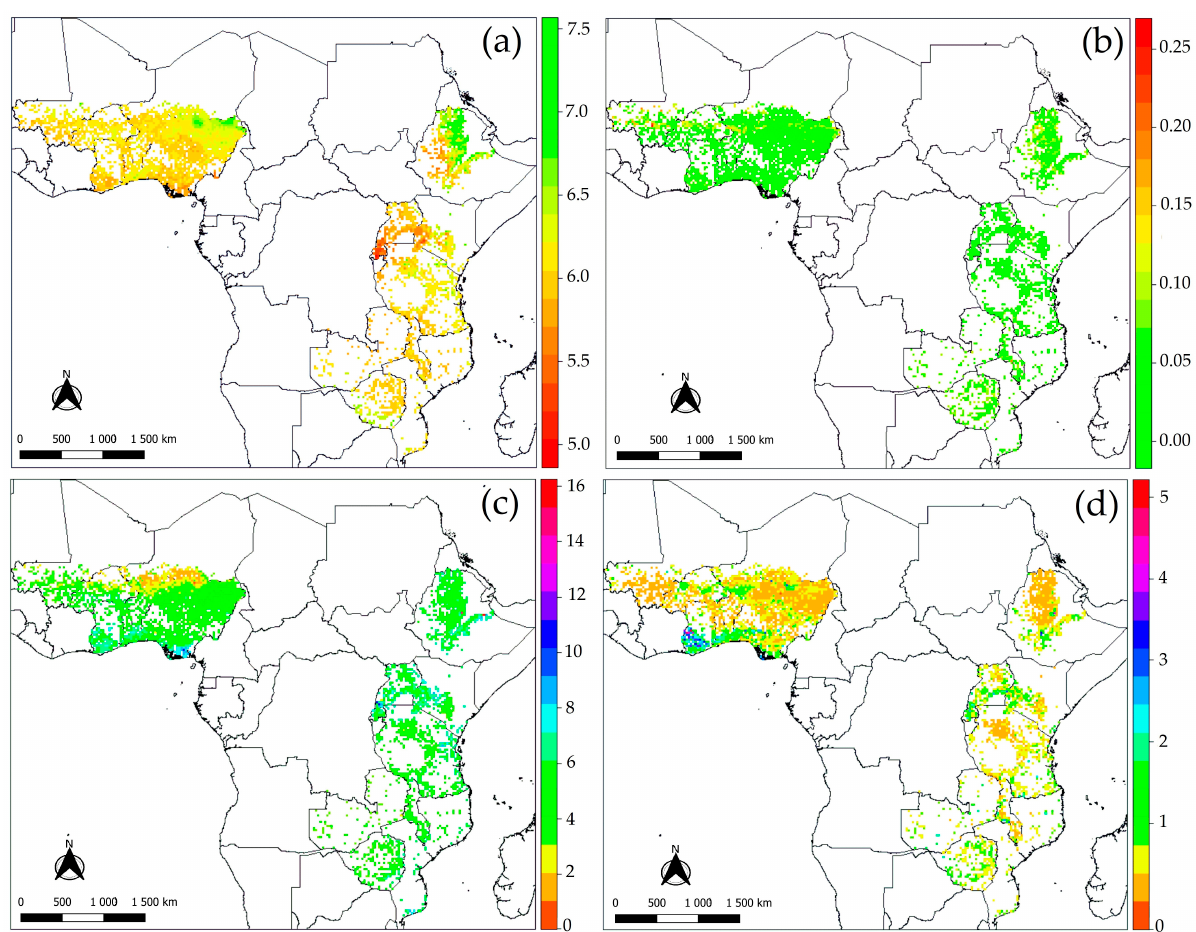
Figure 6. Uncertainties assessment of predicted soil pH and soil acidification: prediction soil pH ( a ), standard deviation map of soil pH (pH unit) ( b ), soil acidification map ( c ) and standard deviation map of soil acidification (keq H + ha − 1 yr − 1 ) ( d ).